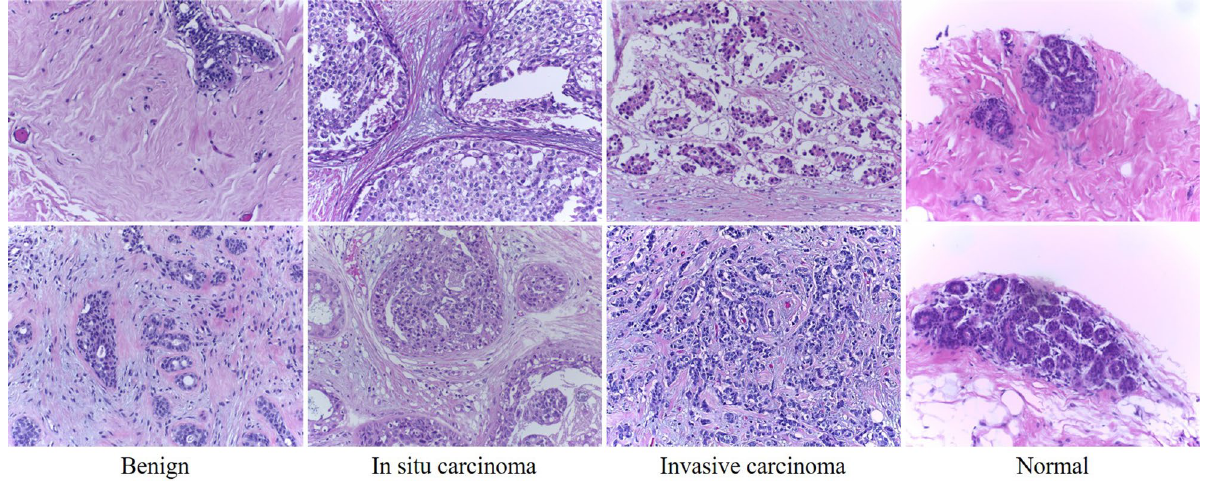
Figure 6. Microscopic H &E images of four types of tumors from the BACH dataset (200 ×